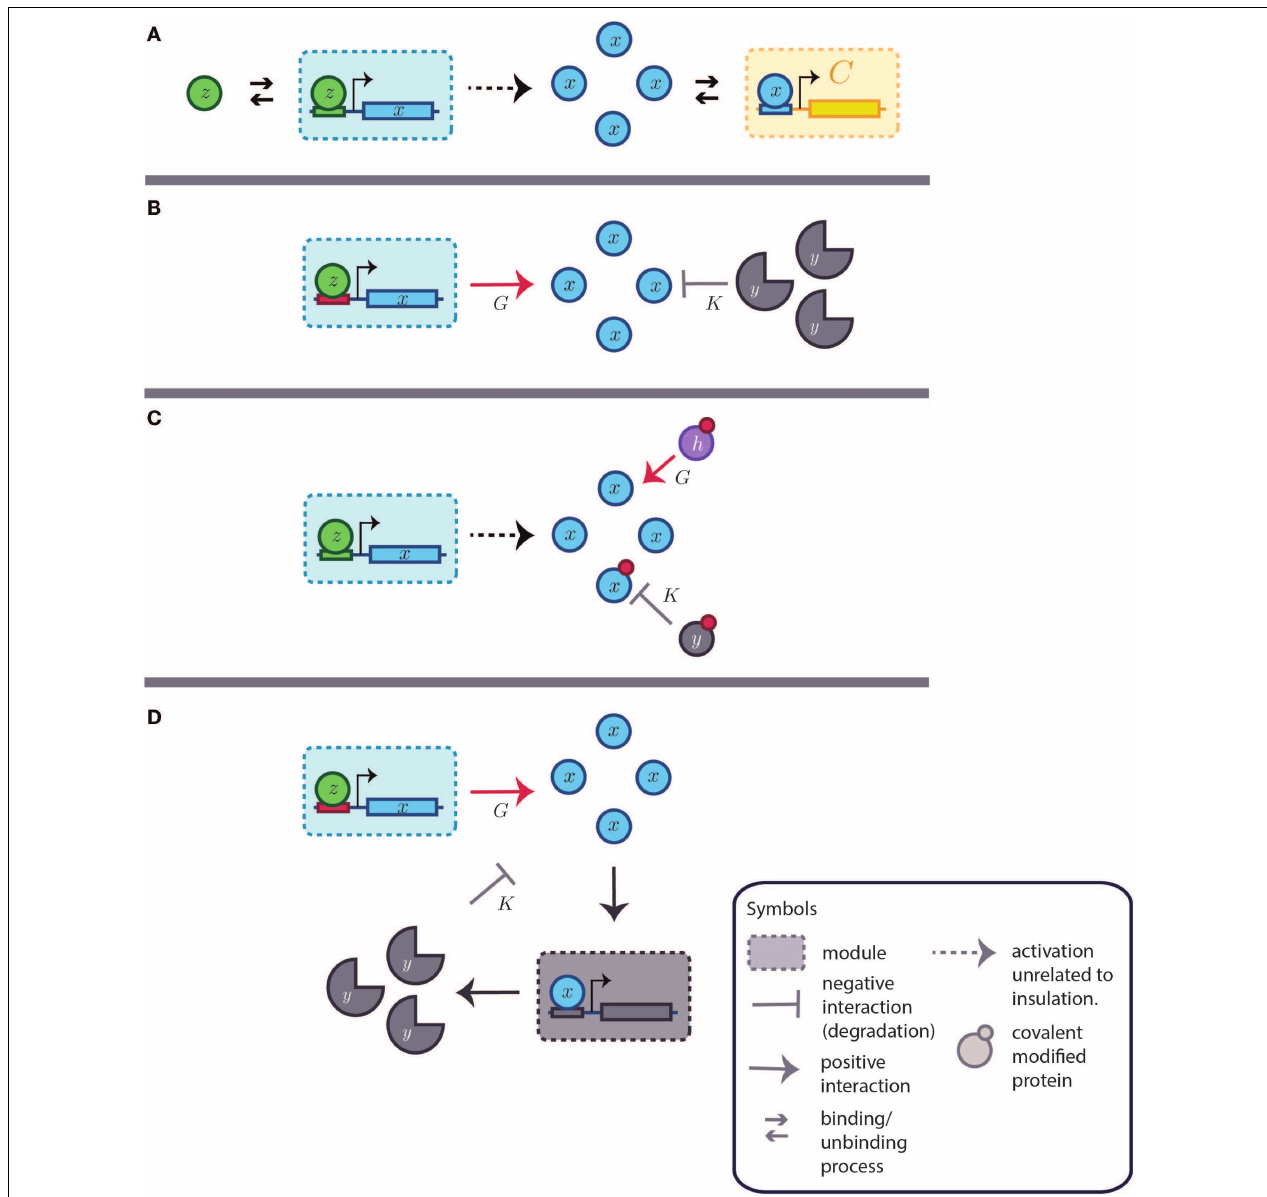
under the upstream module. The big arrow denotes the output production. The downstream module (in yellow and denoted by C ) is obviated in the next items for simplicity. As in Figure 5 , the blue module can be considered analogous to module A and the yellow one is equitable to B . (B) Gain amplification- degradation. Amplification is attained by using a strong and non-leaky binding site (in red). Degradation is achieved by a protease ( y ). (C) Time-scale insulation by covalent modification of the TF of interest. Amplification is given by a protein ( h ) capable of transducing the covalent signal that activates the TF ( x ). Degradation is caused by another protein ( y ), which removes the modification. (D) Alternative feedback dependent degradation scheme. x promotes the transcription of a degradation agent y